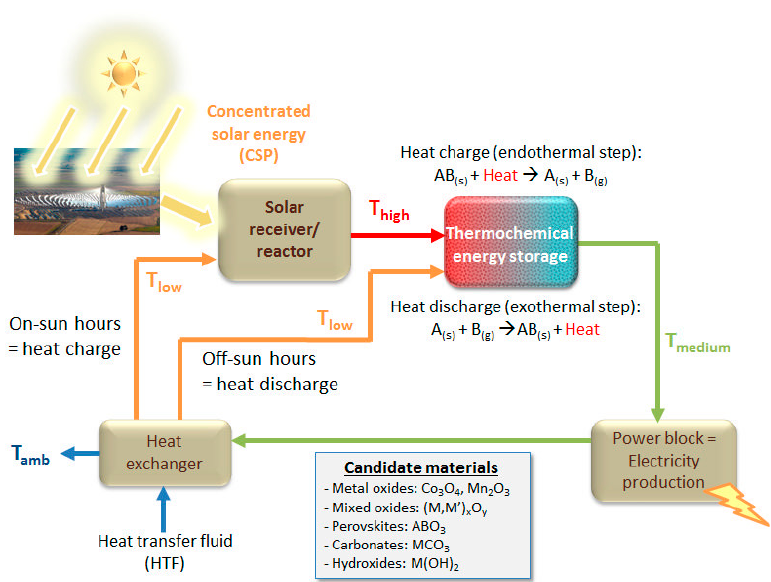
Figure 2. Flow diagram and operating principle of thermochemical energy storage system integrated with solar thermal power plant for continuous power production.